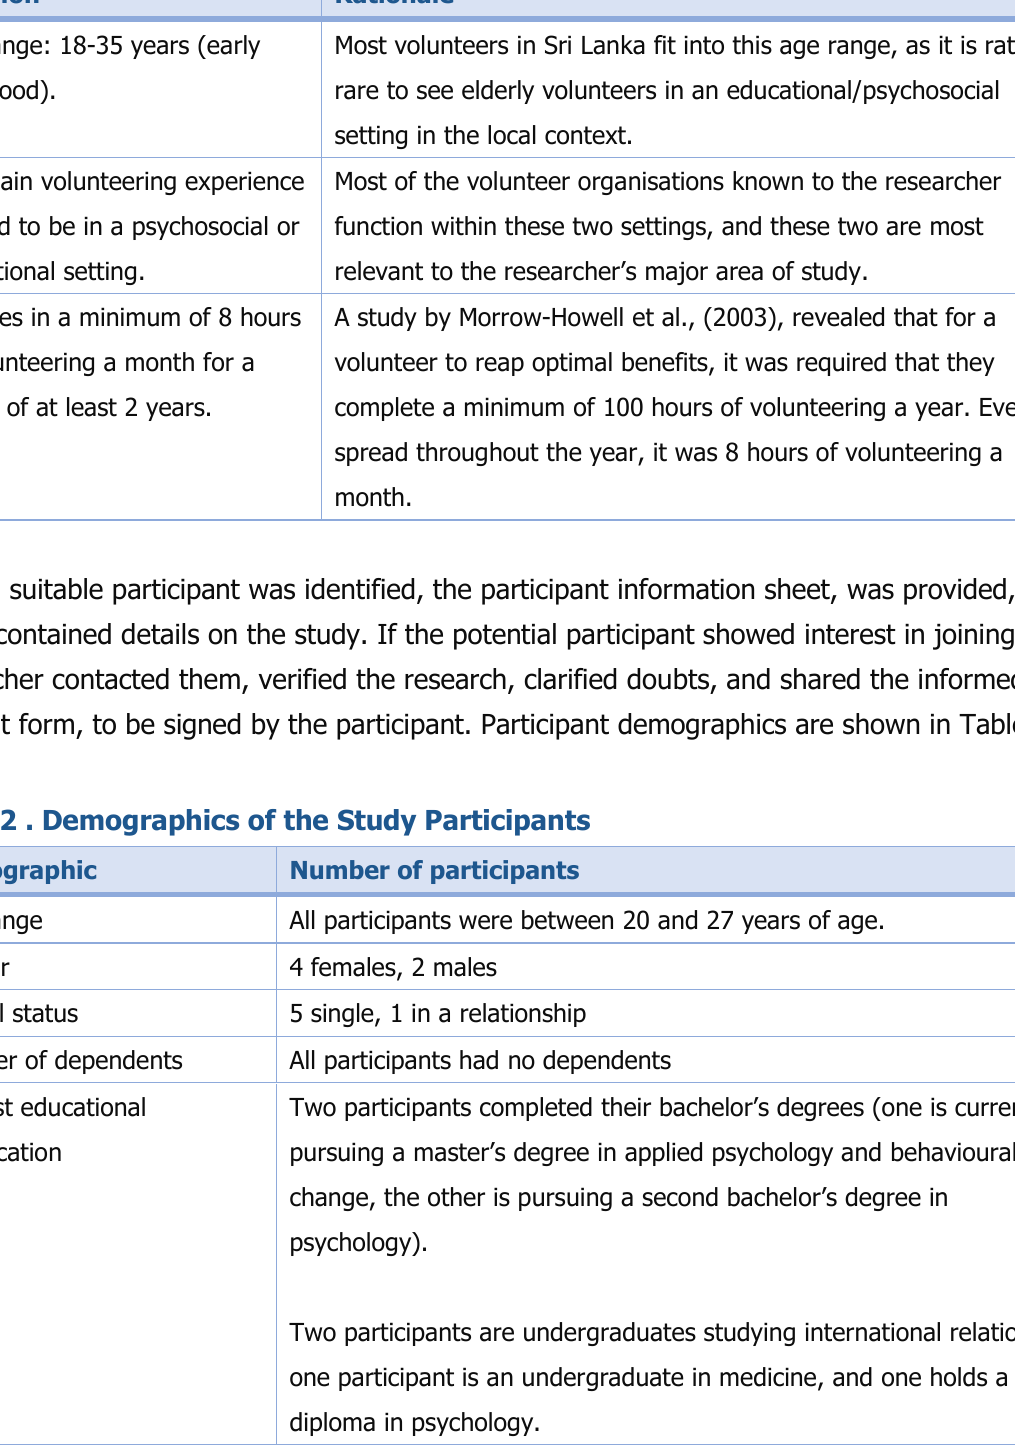
Table 1. Inclusion Criteria (Based on Rationale) for Participants in the Study Criterion